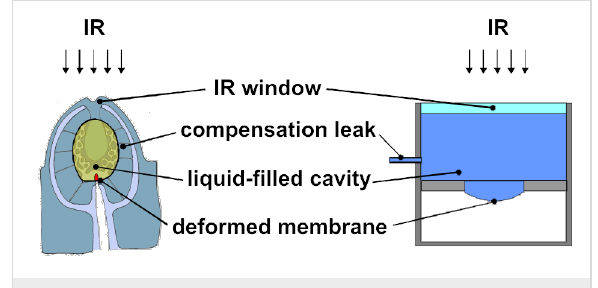
Figure 4: Comparison of the sensillum (left) with the model of the sensor